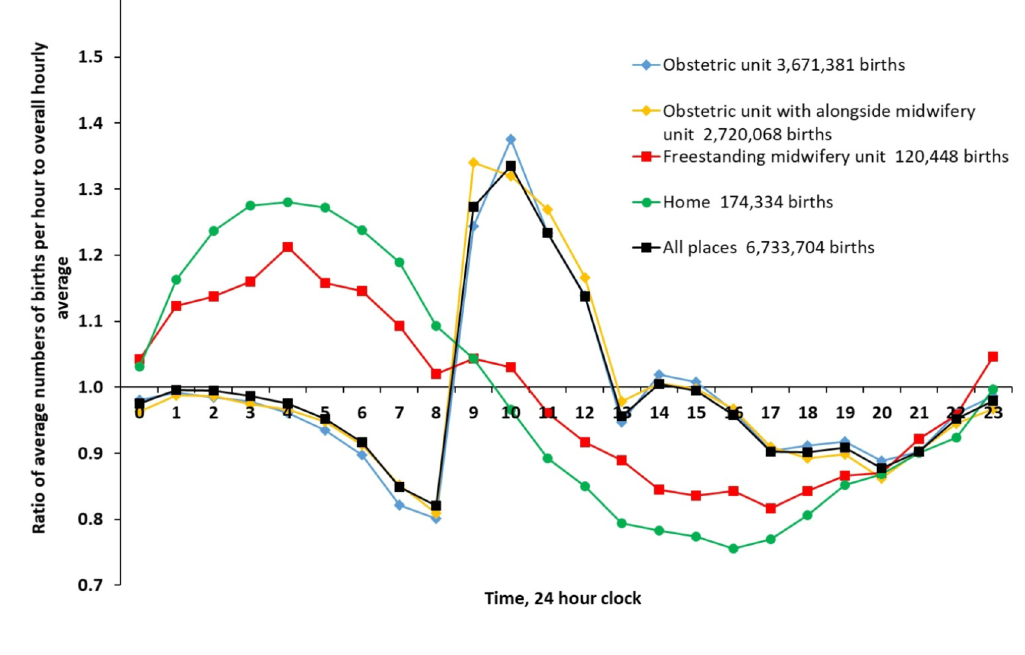
Figure 2: Variations in singleton births by time of day in NHS maternity units (obstetric units, alongside midwifery units, freestanding midwifery units) and at home, England and Wales, 2005-14. Obstetric units with alongside midwifery units have combined data.